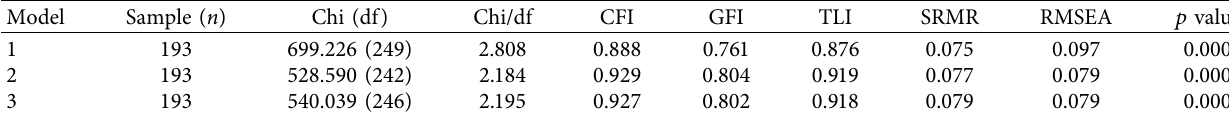
Table 4: Fit indices of the three proposed